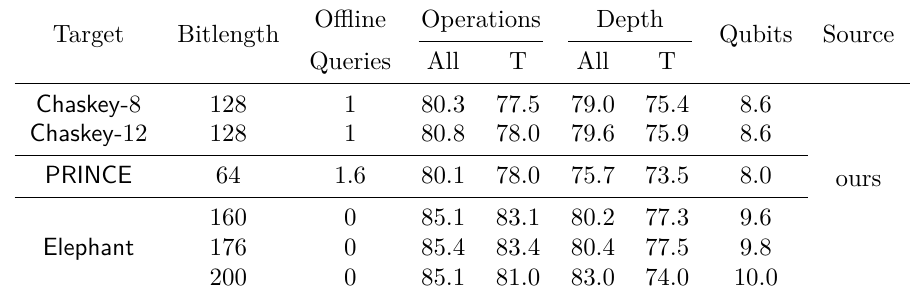
Table 4: Attack costs of quantum exhaustive key search using an STO approach. All figures in log base 2 except